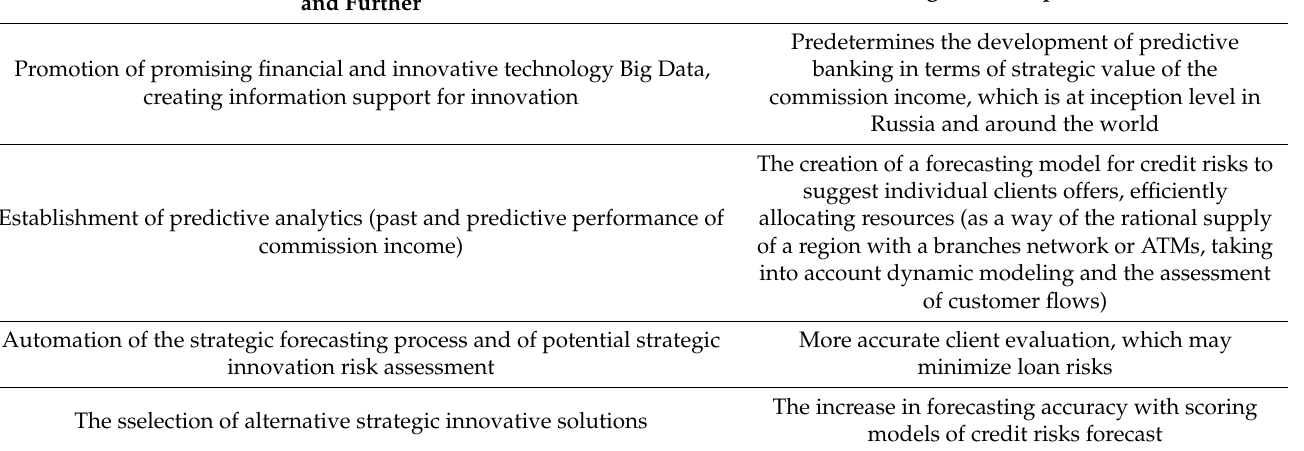
Table 4. Main practical application areas of adapted financial and innovative technology Big Data. Adapted Data Mining Method–Monte Carlo in the Moment of